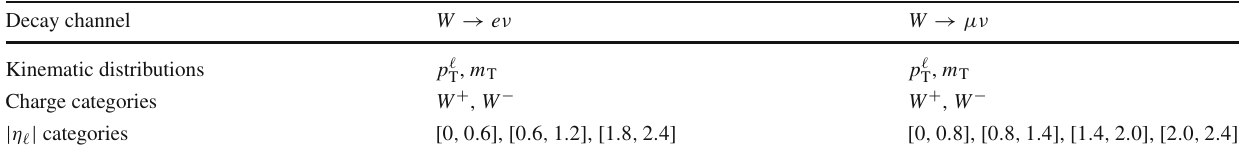
Table 1 Summary of categories and kinematic distributions used in the m W measurement analysis for the electron and muon decay channels Decay channel Kinematic